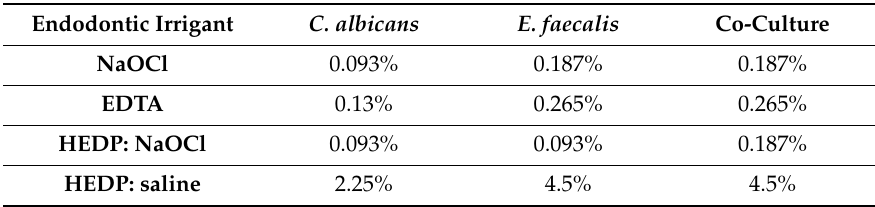
Table 1. Susceptibility of planktonic Candida albicans , Enterococcus faecalis and their co-cultures to sodium hypochlorite, EDTA and HEDP. Numbers represent PMIC